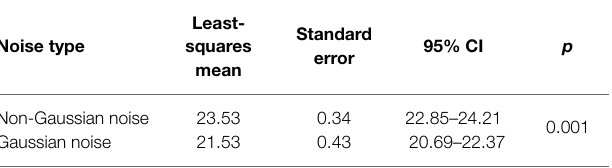
TABLE 2 | Comparison of least-squares mean of NIPTS 346 between non- Gaussian noise and Gaussian noise.